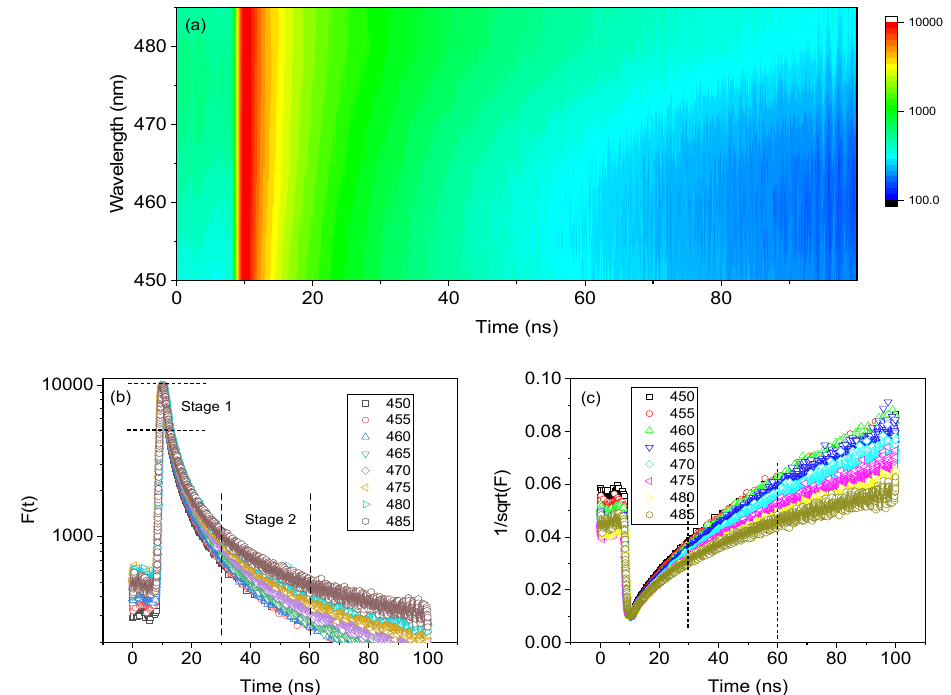
Figure 4. ( a ) The time ‐ resolved PL decay mapping monitored at different detection wavelengths (450–485 nm) excited at a fixed wavelength (375 nm). ( b ) The time ‐ resolved fluorescence decay spectra at different emissions (420, 460, 500, 540, and 600 nm). The detection bandpass was fixed to be 1 nm. Two stages are selected. ( c ) The time ‐ resolved fluorescence decay curves are transformed to 1 (cid:3493)𝐹(cid:4666)𝑡(cid:4667)⁄ versus t .